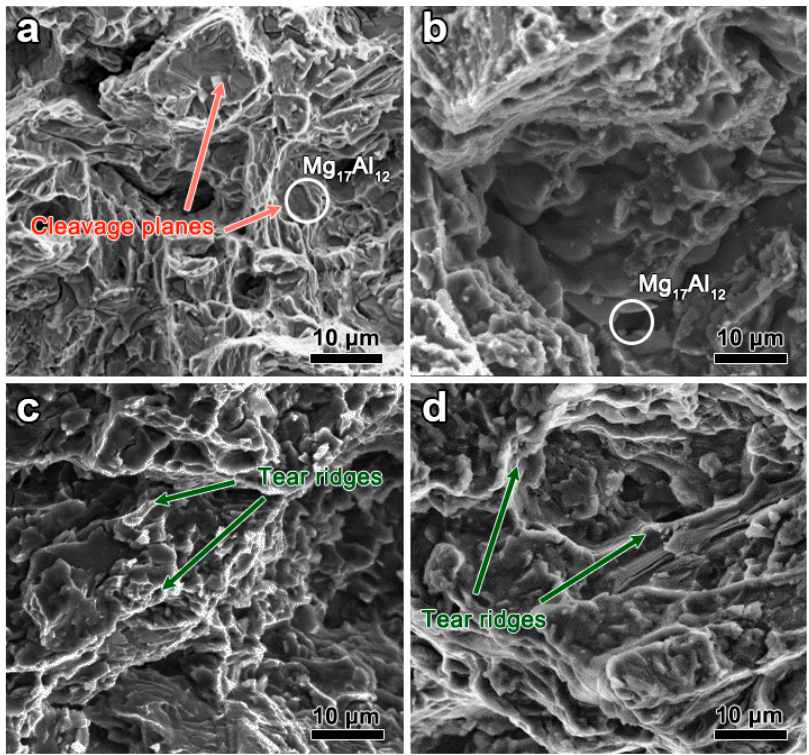
Figure 8. Representative SEM fracture morphology of ( a ) AZ91, ( b ) AZ91–0.5La, ( c ) AZ91–1.0La